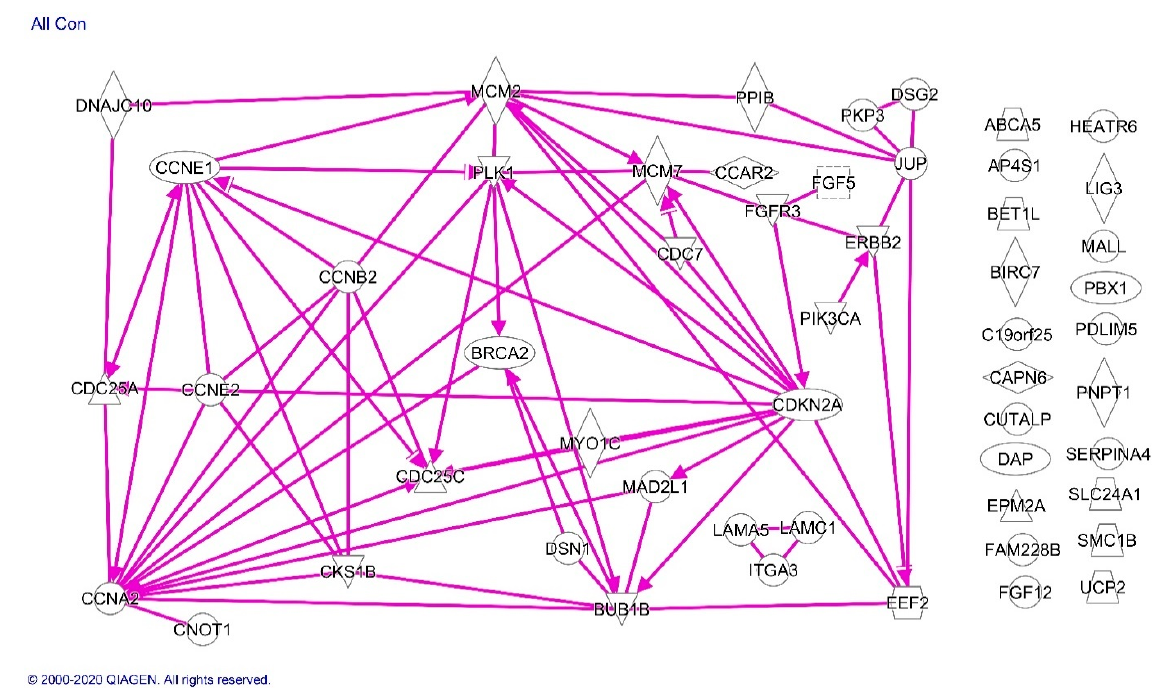
Figure 4. Ingenuity analysis of proteins differentially expressed in endometrioid endometrial cancer specimens from Black compared with White patients. Solid lines indicate direct effects of the indicated protein on the protein to which the arrowhead is pointing. Proteins without arrows had no evidence of a connection with the other proteins in the current scientific literature.